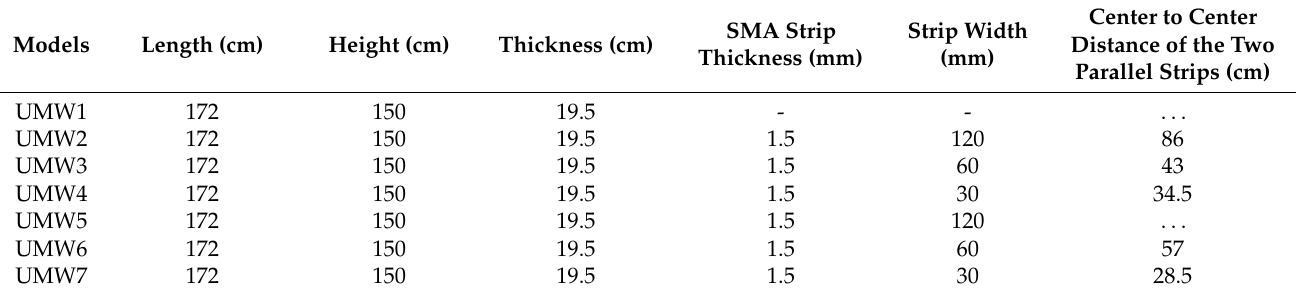
Table 3. Geometric properties of numerically studied